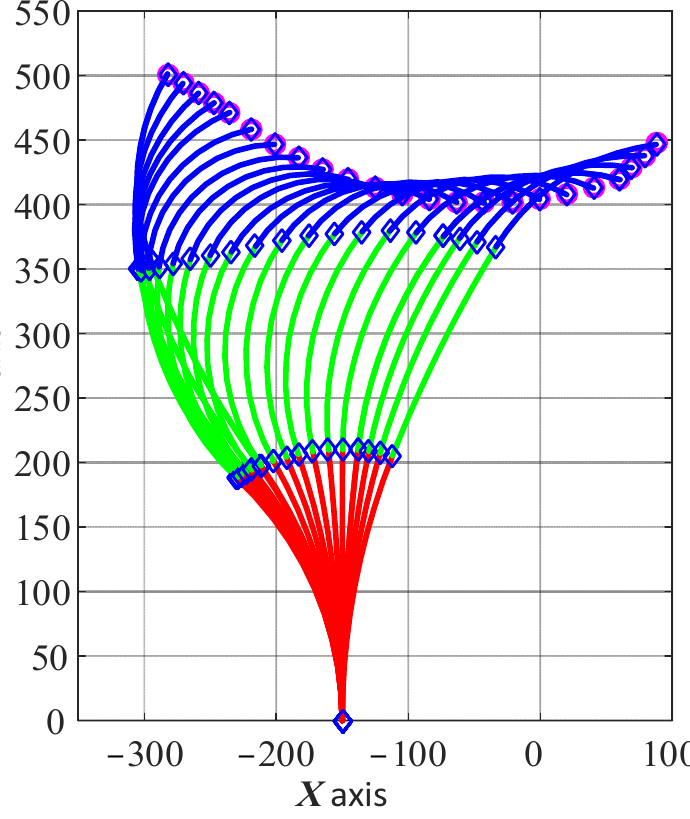
Figure 10. Change in shape of the 6-DoF continuum arm while the end effector moves along the toolpath with the additional constraints of the phase angle.